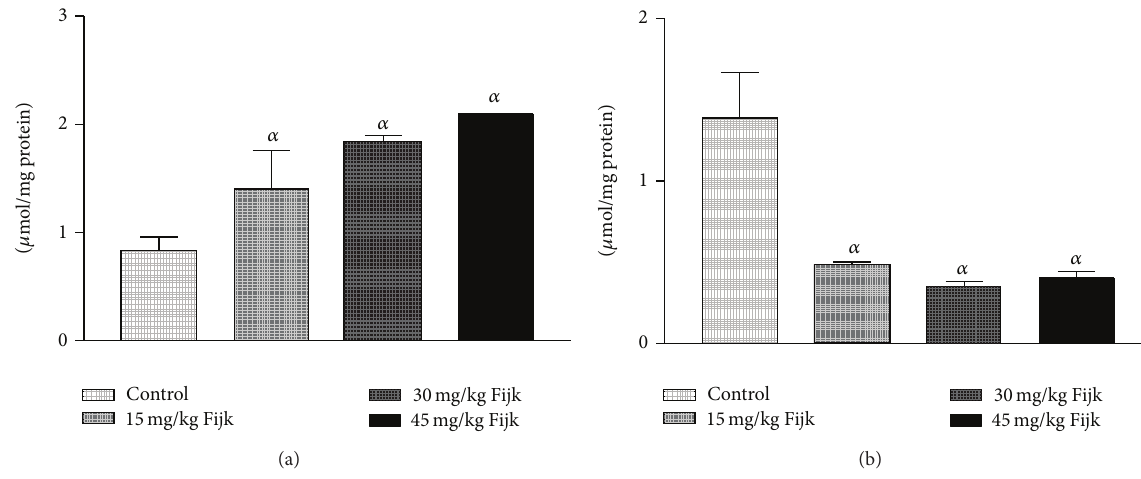
Figure 6: (a) Level of rat plasma malondialdehyde following repeated and oral exposure to Fijk herbal at different dosages; (b) level of rat plasma reduced glutathione following repeated and oral exposure to Fijk herbal at different dosages. Data are presented as mean value ± standard error of mean (SEM), 𝑛 = 6 . 𝛼 is significant at 𝑃 < 0.05 relative to control.